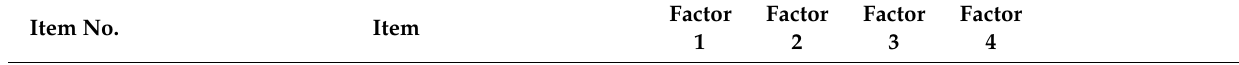
Table 3. Factor loading for the 40 items of the My Child’s Play questionnaire. Item